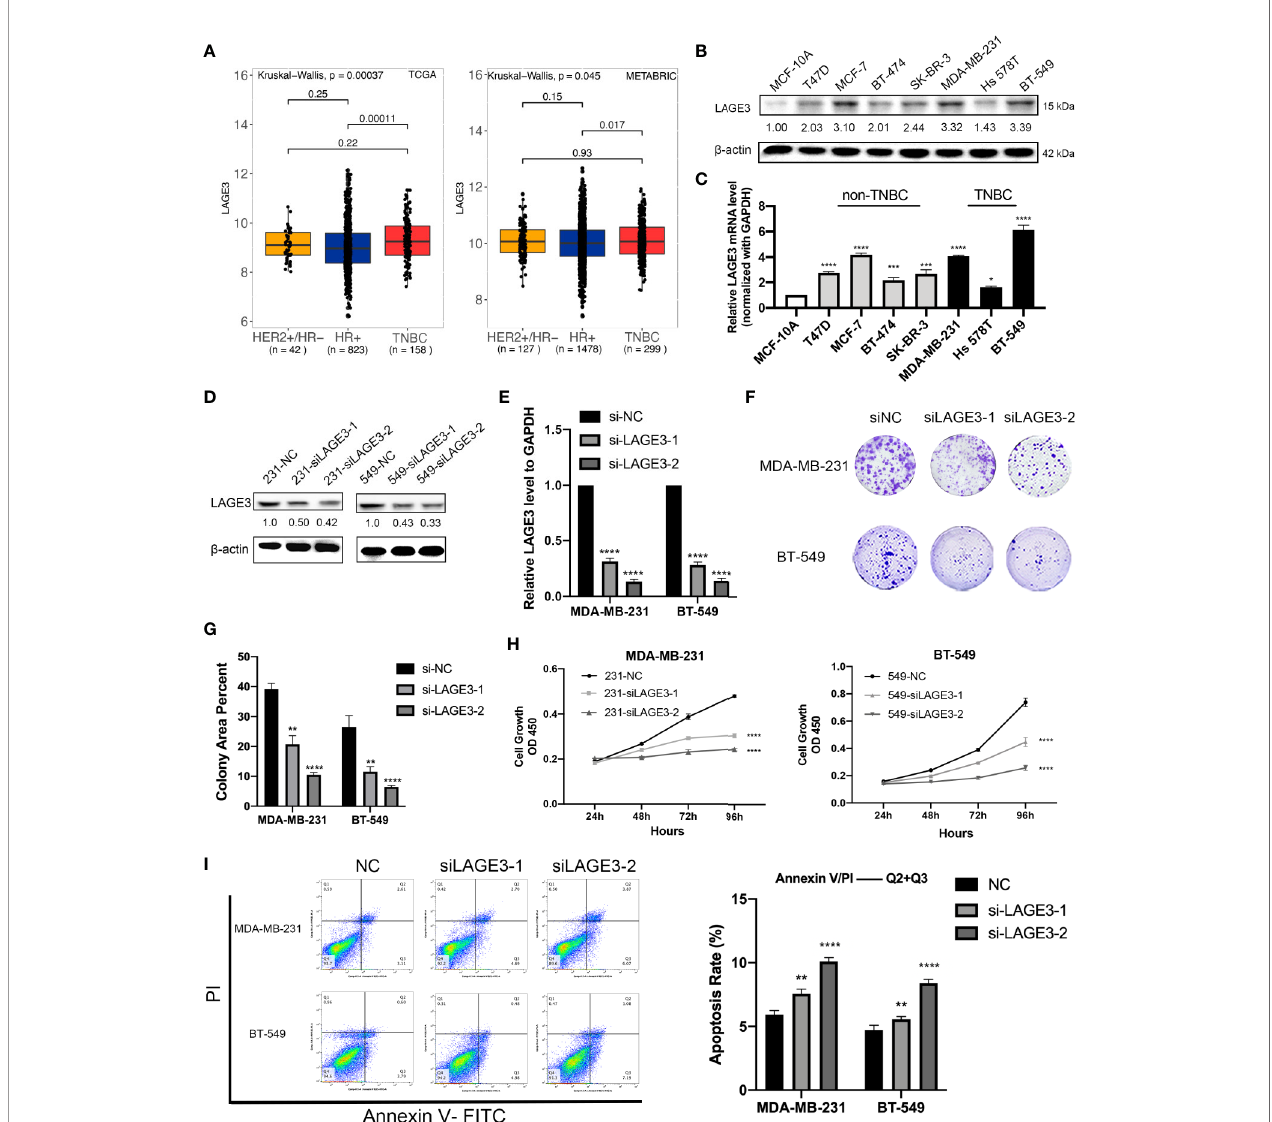
FIGURE 8 | LAGE3 promoted proliferation and suppressed apoptosis of TNBC cell lines. (A) Box-and-whisker plot showing the expression of LAGE3 in various subtypes of BCs. (B, C) Protein and transcriptional level of LAGE3 in non-malignant MCF-10A cells and various BC cell lines. (C, D) Protein and mRNA level of LAGE3 in TNBC cell lines transfected with either negative control (si-NC) and LAGE3 targeting siRNA (si-LAGE3-1 or si-LAGE3-2). (E, F) Colony formation assay and (G) CCK-8 assay was showing the proliferation of cells transfected with si-NC or si-LAGE3. (H) Flow cytometry assay showing the number of apoptotic cells in different groups. Multiple groups were compared using unpaired Student ’ s t-test (two ‐ tailed). *p < 0.05; **p < 0.01; ***p < 0.001; ****p <